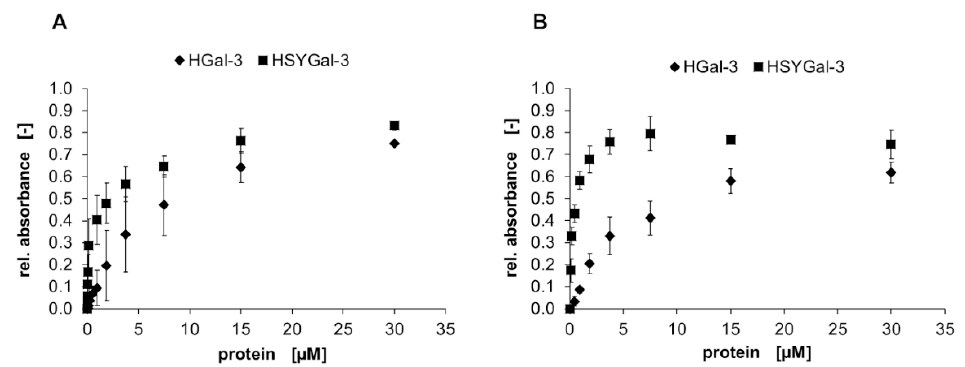
Figure 3. Comparison of Gal-3 binding on ASF depending on the purification mode. The binding of HGal-3 ( (cid:4496)(cid:4497) ) and HSYGal-3 ( ⬛ ) is shown for IMAC-purified ( A ) and IMAC/ASF-resin-purified ( B ) galectins. Galectin binding was detected with a peroxidase-conjugated anti-His 6 -antibody and conversion of TMB as the mean signal of three data points. Errors indicate standard deviations. Table 2. Apparent K D values and binding efficiencies of IMAC and IMAC + ASF affinity column purified Gal-3 proteins in a solid-phase assay on ASF. Values were calculated by non-linear regression assuming one-site